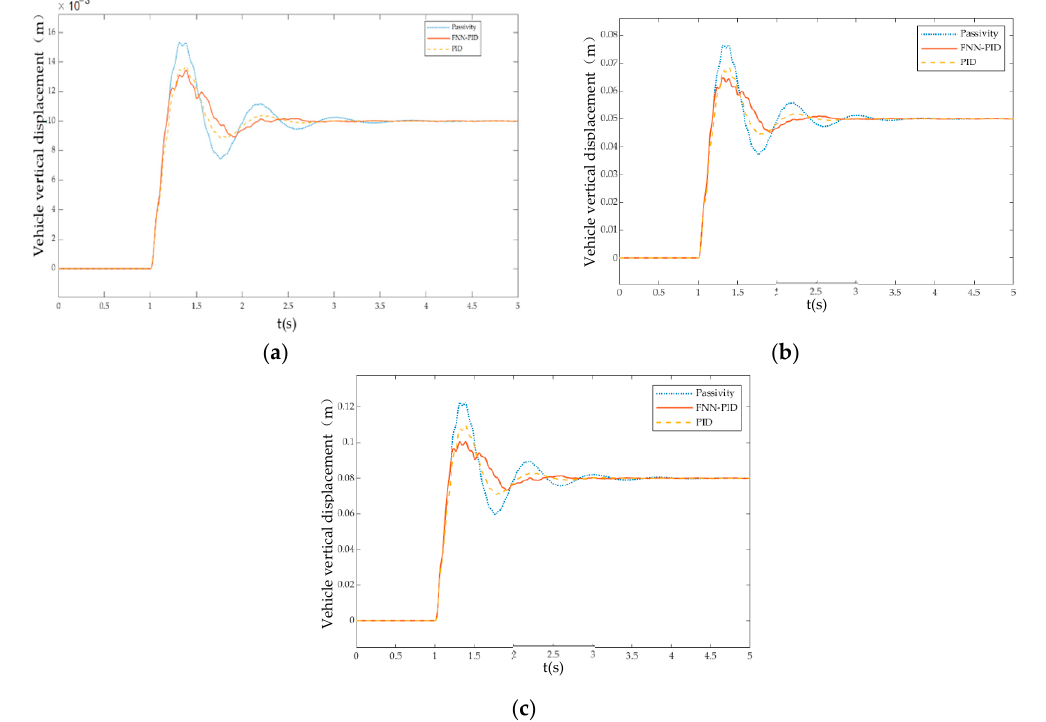
Figure 8. Plot of vehicle vertical displacement change under step signal. ( a ) The step signal is 0.01 m. ( b ) The step signal is 0.05 m. ( c ) The step signal is 0.08 m.